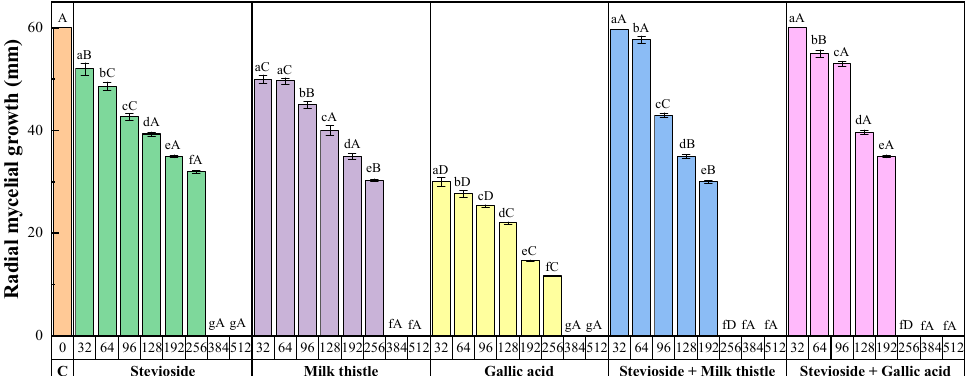
Figure 2. Radial growth values of F. culmorum in the presence of stevioside, gallic acid, milk thistle seed extracts, and the stevioside–polyphenol (i.e., stevioside–gallic acid and stevioside–milk thistle seed extract) conjugate complexes at different concentrations (expressed in µg·mL − 1 ). Concentrations labeled with the same lowercase letters are not significantly different at p < 0.05 by Tukey’s test. Treatments labeled with the same uppercase letters are not significantly different at p < 0.05 at the indicated dose. All values are presented as the average of three replicates and two repeats. Error bars represent the standard deviation.